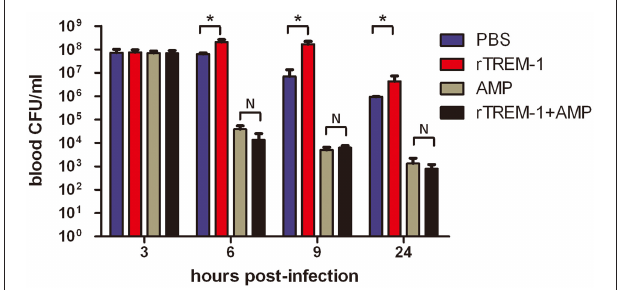
FIGURE 2 | The kinetics of bacterial clearance from the blood of mice. Mice were infected with a highly virulent S. suis strain and treated with PBS, rTREM-1, antibiotics, or antibiotics+rTREM-1 at 3h post-infection, and the colony forming units (CFU) in blood were compared at 6, 9, and 24h post-infection. “ * ” represents p < 0.05 for the two selected groups, and “N” represents no significant difference for the selected groups at the given time-point.